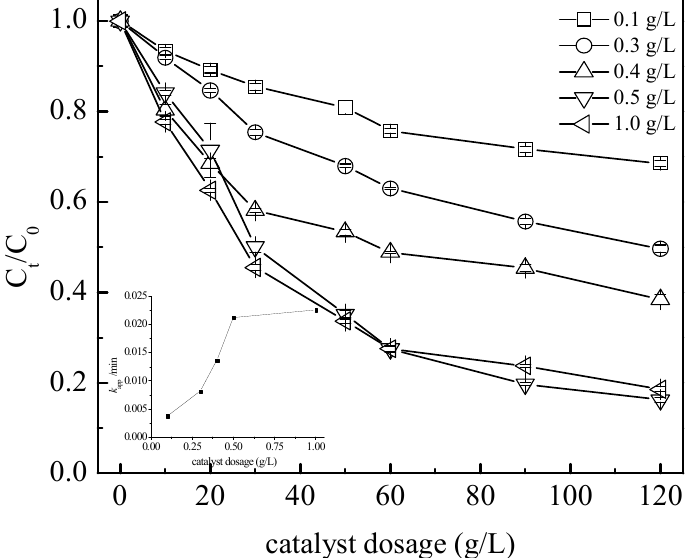
Figure 6. Effect of the BA catalyst dosage on the TC degradation. Conditions: C 0 = 100 mg L − 1 , [PS] = 50 mM, and pH 0 = 3.7.